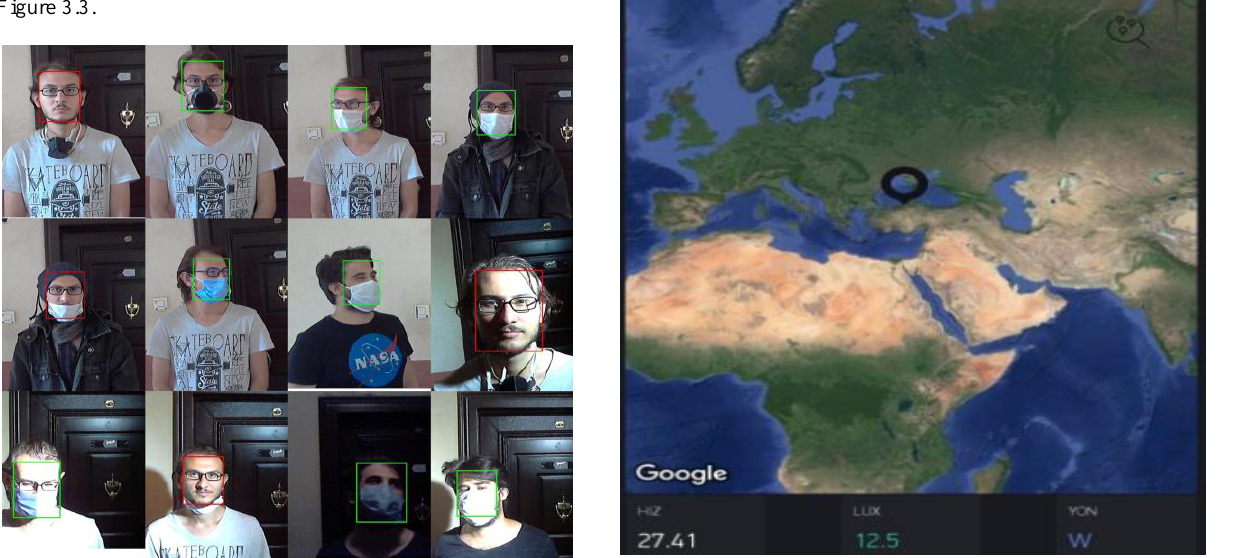
Figure 3.3. Experimental Study Examples